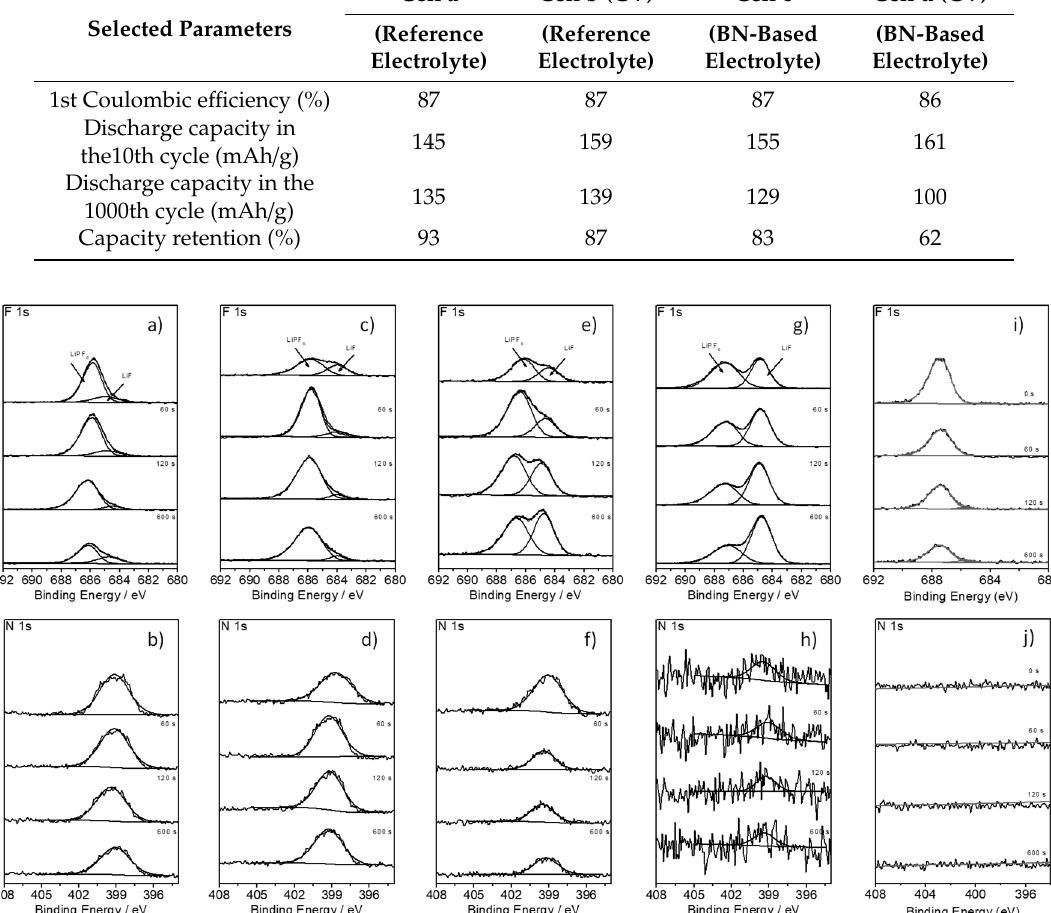
Figure 8. F 1s and N 1s core spectra of graphite electrodes, after five charge/discharge cycles at 0.1C in a NMC/graphite cells with different amounts of FEC in the electrolyte: ( a , b ) 1M LiPF 6 in BN, ( c , d ) 1M LiPF 6 in BN + 5% FEC, ( e , f ) 1M LiPF 6 in BN:EC (9:1) + 2% FEC, ( g , h ), 1M LiPF 6 in BN:EC (9:1) + 3% FEC and ( i , j ) pristine electrode.